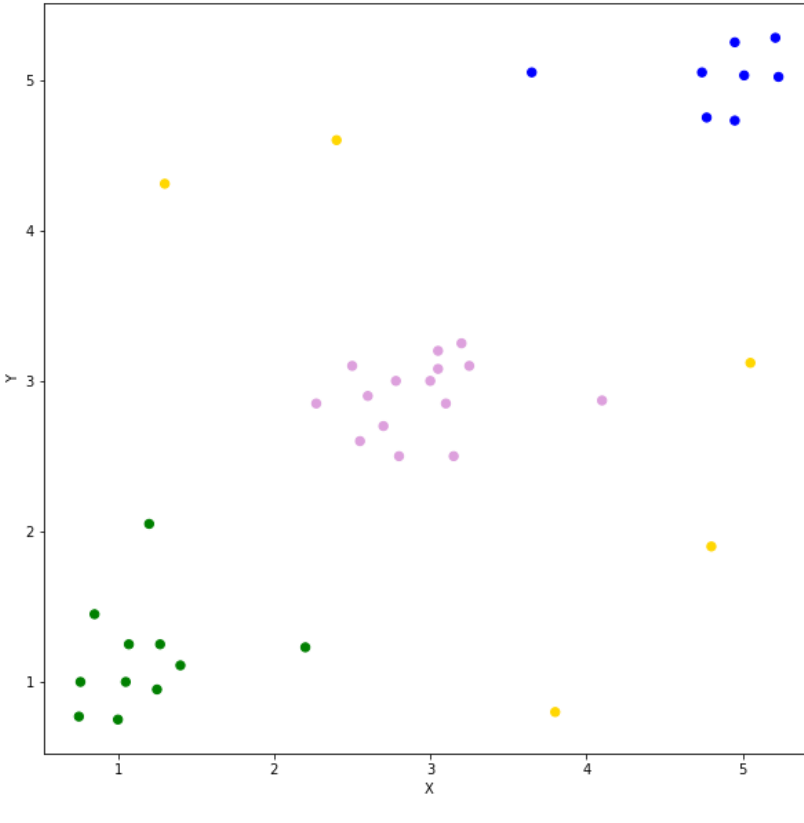
Figure 5. The clustering result produced by HDBSCAN* using the simple